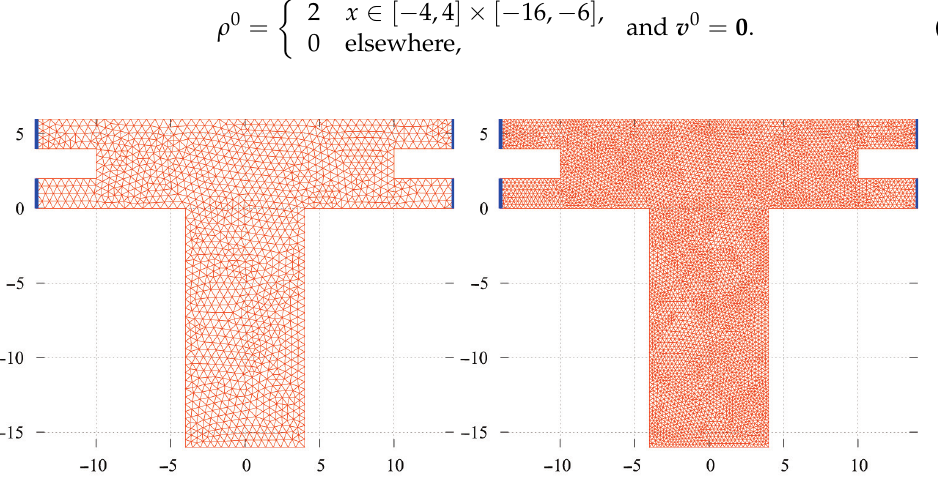
Figure 9. T-shape domain, computational grids (FV-DG) with # T h = 2578 ( left ) and # T h = 10,848 ( right ) elements, the exits are marked by the blue color.